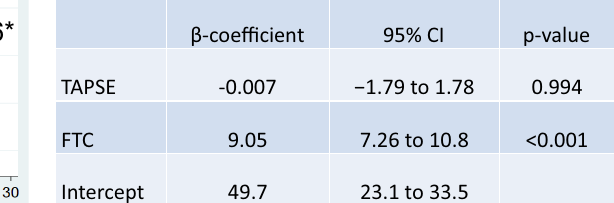
(dependent variable: RVEF, standardized using mean and standard deviation). R 2 (cid:18457) 0.106*